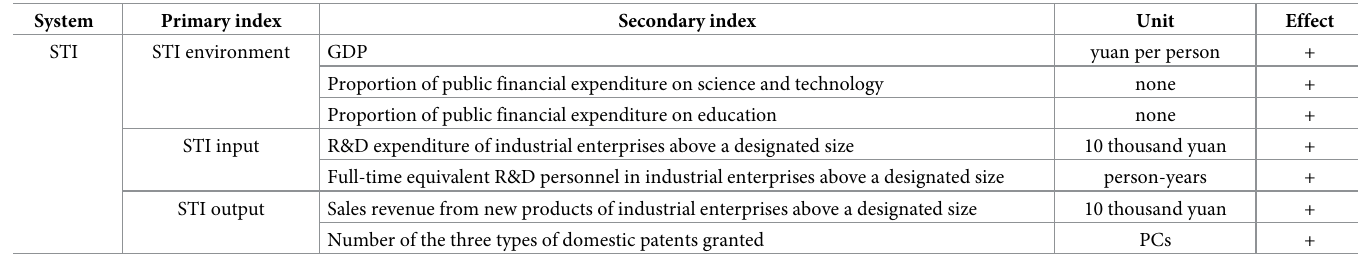
Table 3. Measurement system for STI.